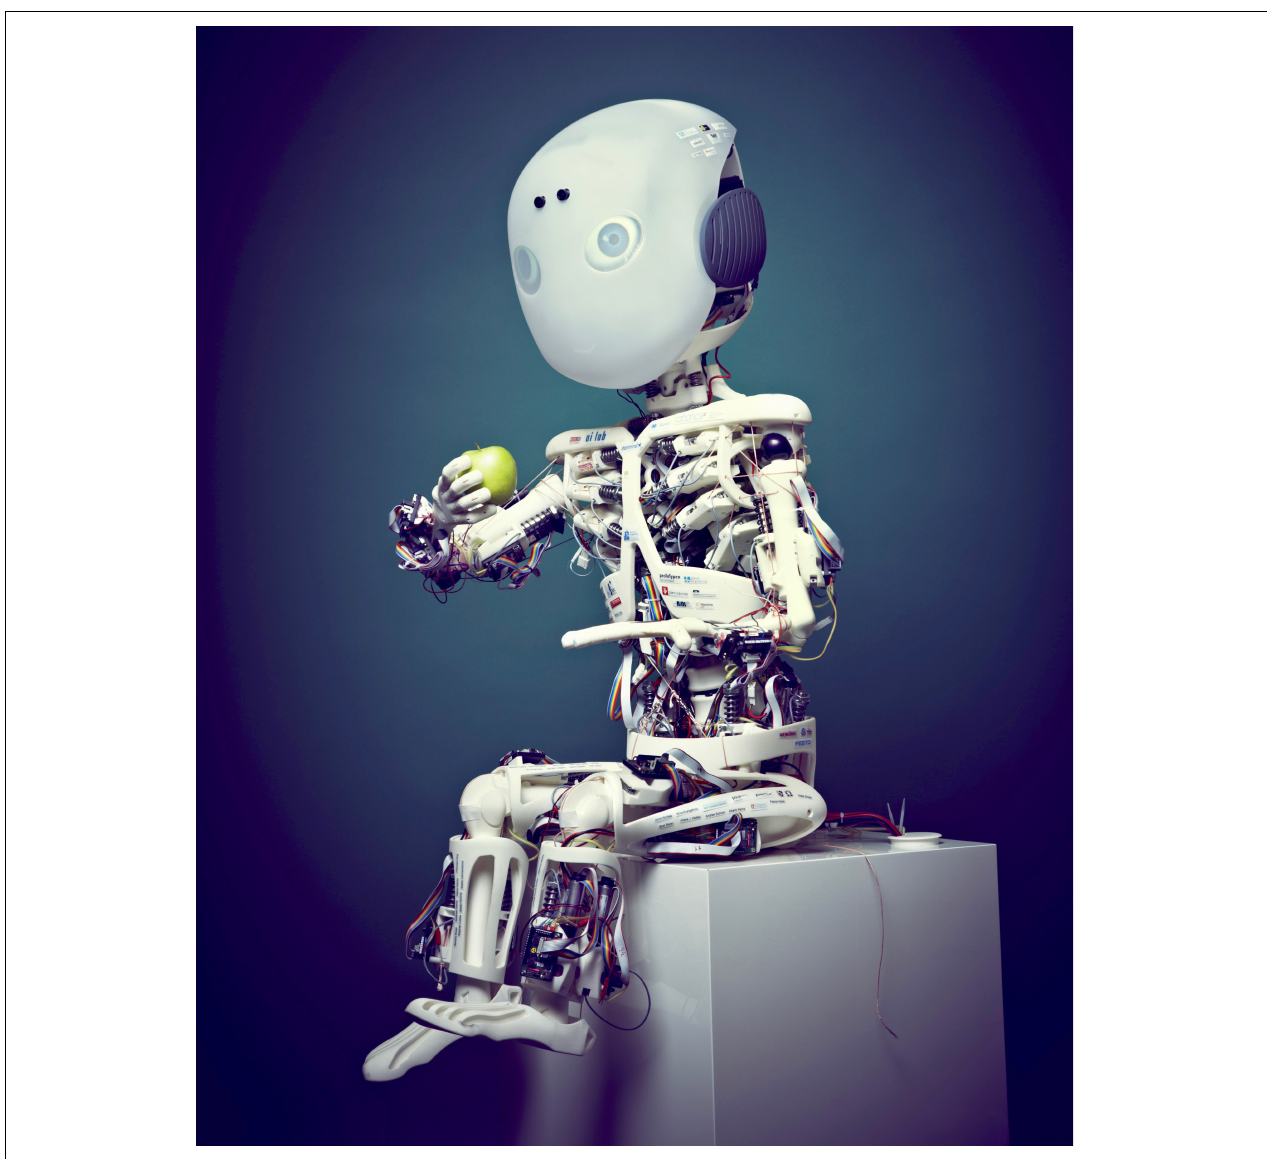
FIGURE 1 | The musculoskeletal humanoid robot